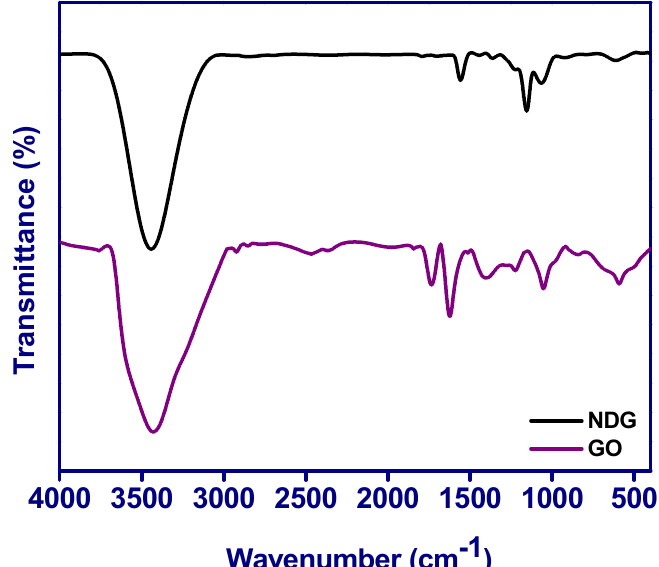
Figure 2. FT-IR spectra of GO and NDG.